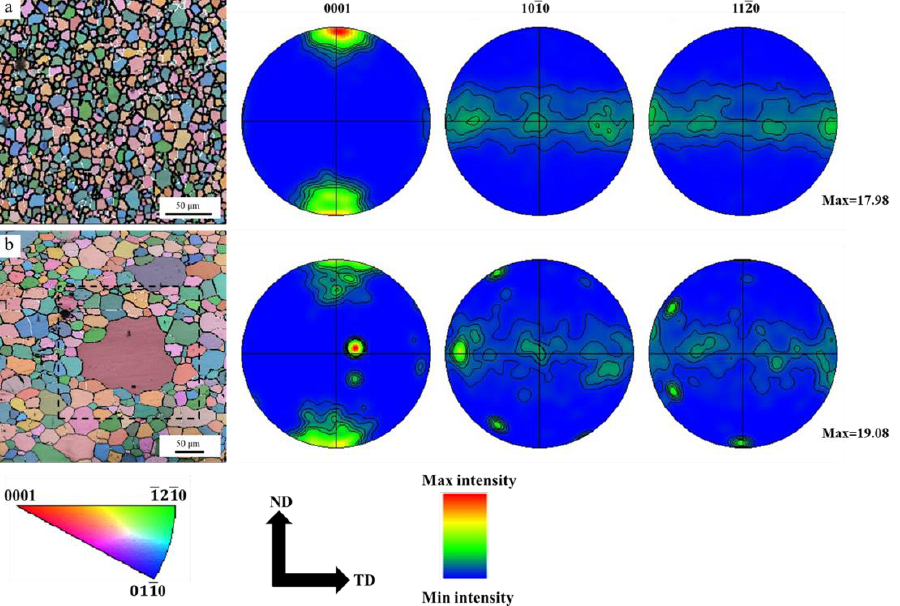
Figure 18. IPF and pole figure (PF) maps of AZ61 with different annealing times. ( a ) Initial specimen, ( b ) 350 ◦ C annealing for 72 h. White lines correspond to low-angle grain boundaries with misorientations of 2 ◦ < θ < 15 ◦ and black lines correspond to high-angle grain boundaries with misorientations θ > 15 ◦ .